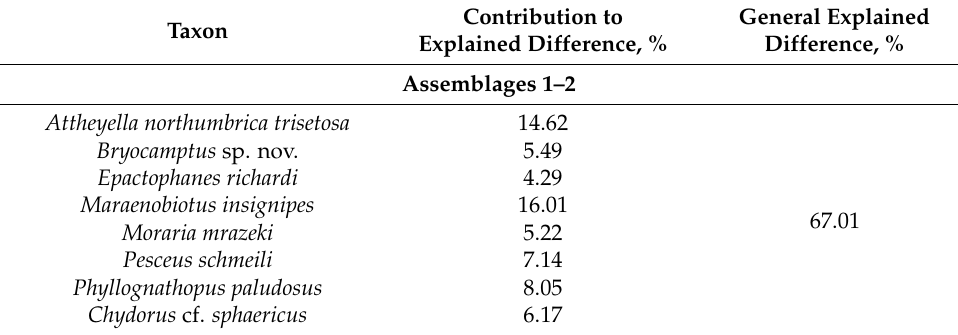
Table 6. Differentiating species of meiobenthic crustacean assemblages from central part of Putorana Plateau (meaning of assemblage numbers in Table